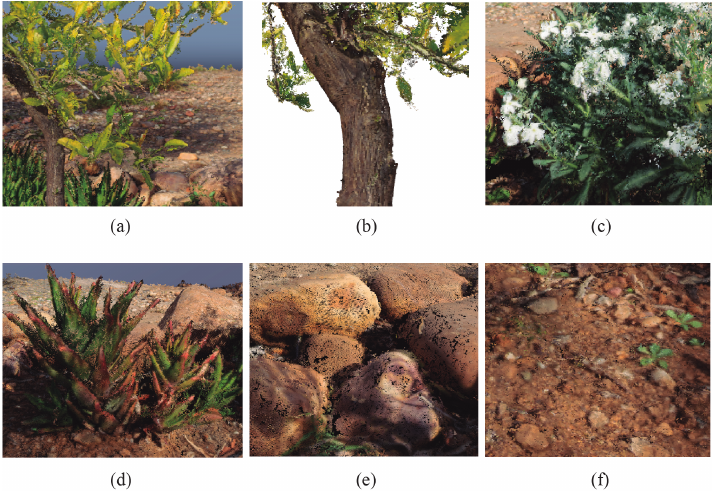
Figure 9. The identified materials in the scene. ( a ) leaves, ( b ) wood, ( c ) flowers, ( d ) plants, ( e ) rocks and ( f )